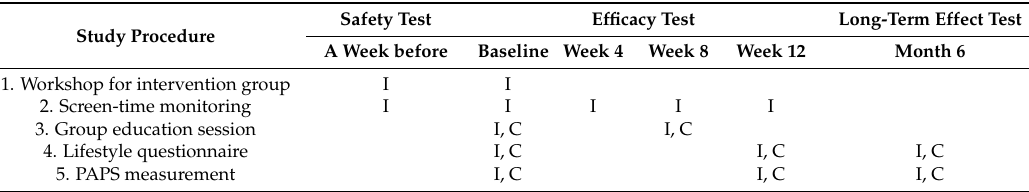
Table 1. Timeline of the study protocol